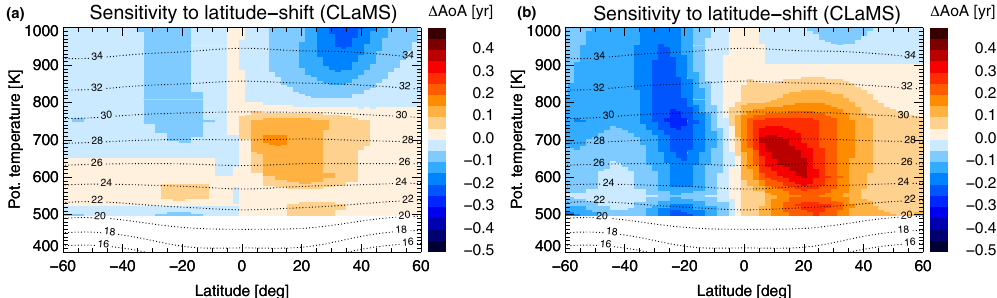
Figure B1. (a) Zonal mean AoA distribution of period I from CLaMS shifted by the shift profile plus 1 σ uncertainty (reducing the shift below 800K); (b) same as (a) , but shifted by the shift profile minus 1 σ uncertainty (increasing the shift below